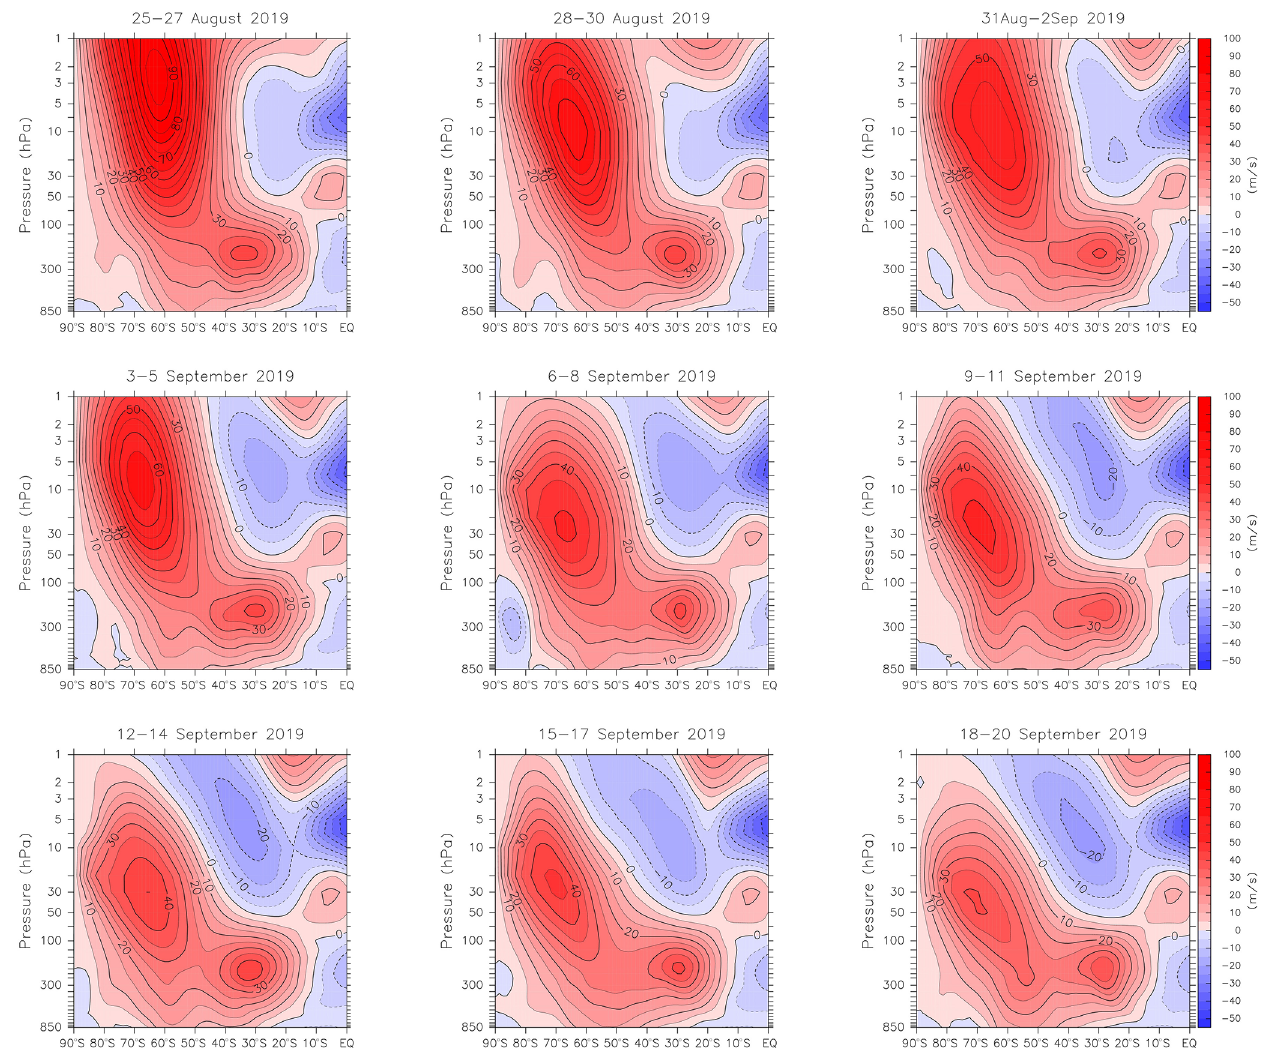
Figure 5. Latitude height cross-sections of zonal-mean zonal wind (ms − 1 ) averaged every 3d from 25 August to 20 September 2019. Contour intervals are 5ms − 1